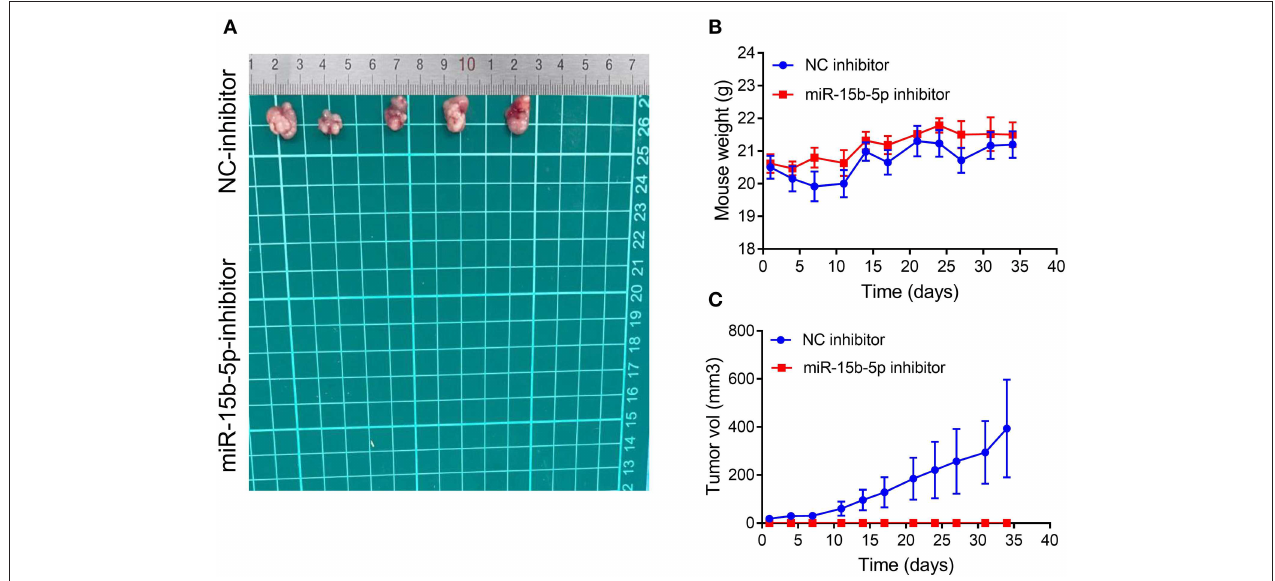
FIGURE 8 | Silencing of miR-15b-5p significantly suppressed tumorigenicity in vivo . (A) After stable transfection of miR-15b-5p or miR-control in MDA-MB-231 cells, cells are harvested and subcutaneously injected into the right or left flank of female nude mice ( n = 5); 5 weeks later, nude mice were executed humanely. Tumors are taken for photographing. (B) Mice were weighed twice per week. Indicated mouse weights = the mean ± SD. (C) Tumor volumes were measured twice per week. The indicated tumor volumes = the mean ±